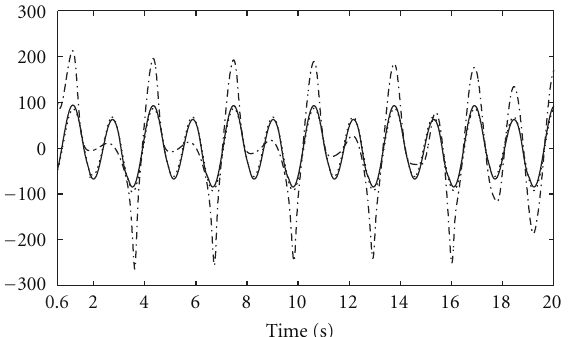
Figure 3: Control u ( t ) on the time interval [0.6, 20]. dash-dotted line for the classical adaptive control, dashed line for the multiple model case ( N = 200) as in [7], and solid line for the multiple identification model in this paper.